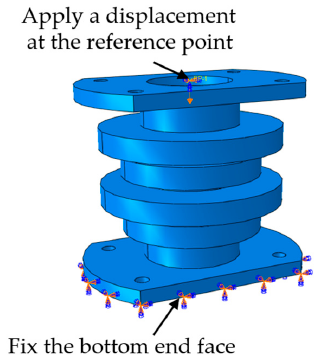
Figure 12. Simulation boundary condition settings.